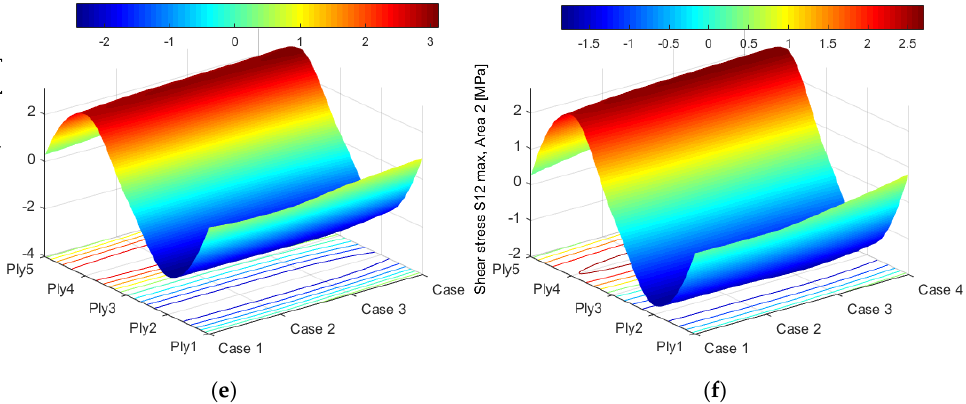
Figure 8. The relationship between the stress distribution and damage effects: ( a ) normal stresses S11 from area 1; ( b ) normal stresses S11 from area 2; ( c ) normal stresses S22 from area 1; ( d ) normal stresses S22 from area 2; ( e ) shear stresses S12 from area 1; ( f ) shear stresses S12 from area 2.